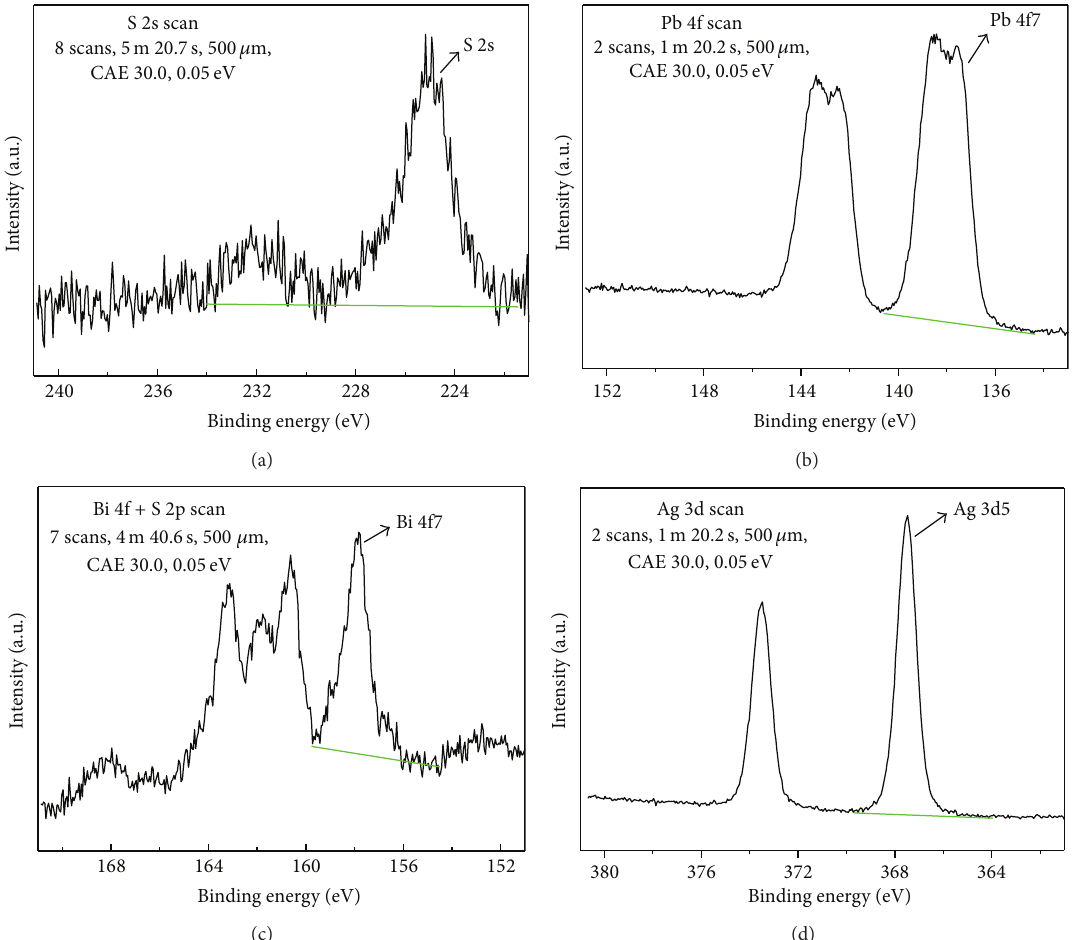
Figure 4: XPS of (a) S 2s peaks, (b) Pb 4f peaks, (c) Bi 4f peaks, and (d) Ag 3d peaks for PbS, Bi-doped-PbS, and Ag-doped-PbS QDs adsorbed on mesoporous TiO 2 surface.